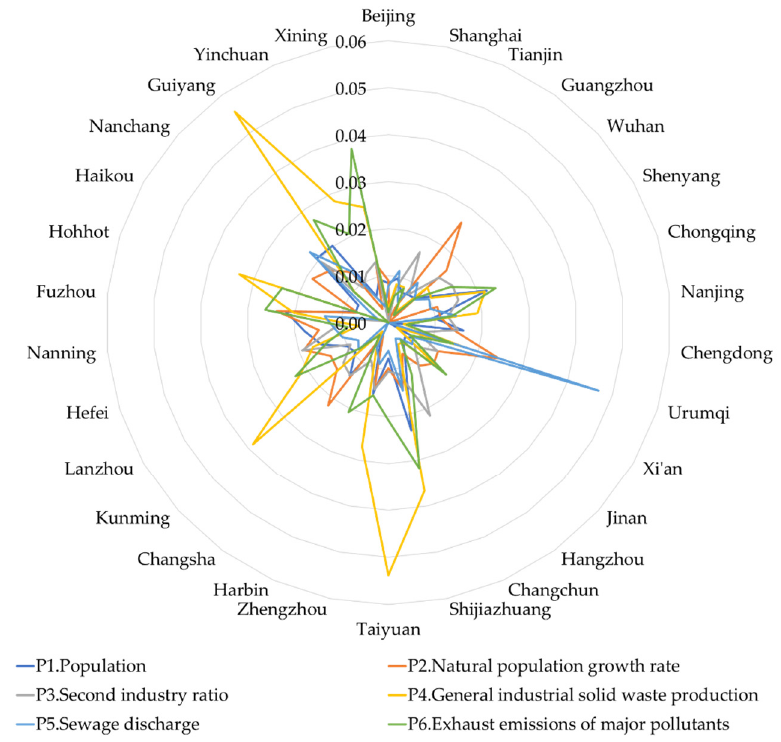
Figure 6. Weighted comparison of sub-indicators in pressure index.